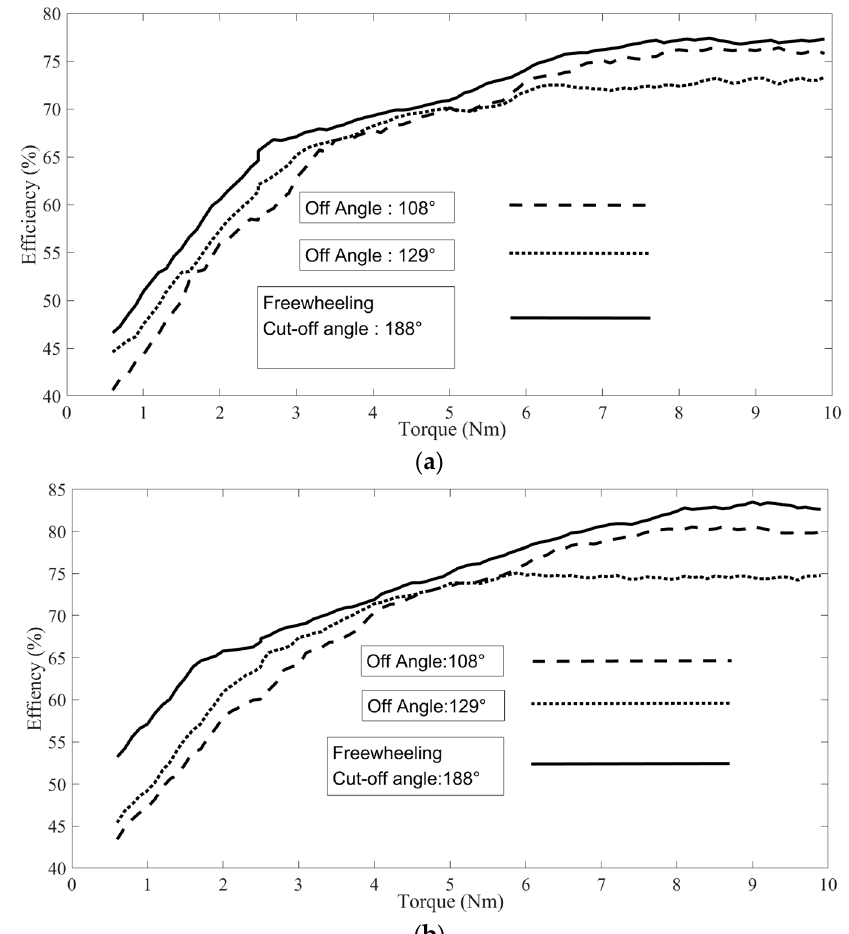
Figure 10. Efficiency comparison of the same speed and different cut-off angles. ( a ) 2000 r/min, efficiency comparison of different cut-off angles. ( b ) 3000 r/min, efficiency comparison of different cut-off angles.